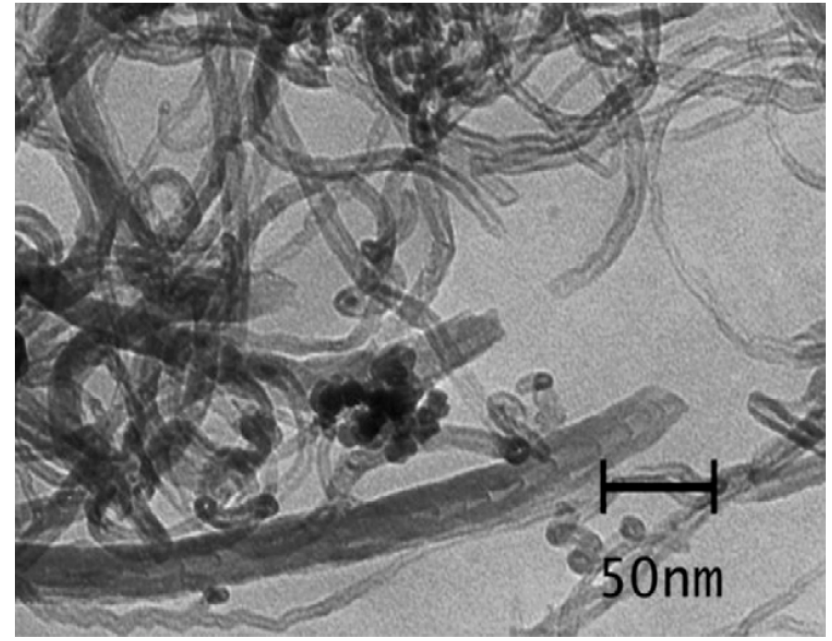
Figure 3. TEM images of magnetic-modified multiwalled carbon nanotubes (CNTs). Reproduced from Ref [61], with permission from Elsevier, 2011.